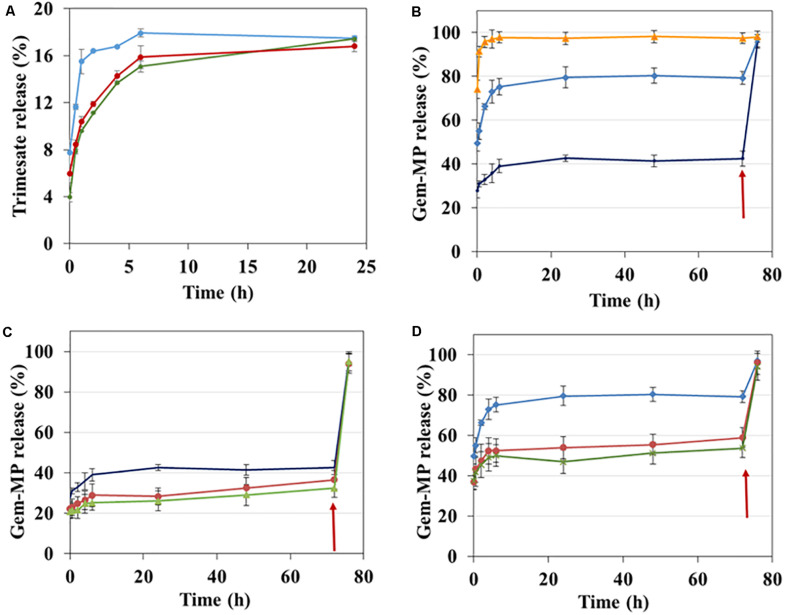
Effect of surface modification on Gem-MP and trimesate release analyzed by HPLC. (A) Trimesate release in 1 mM PBS from nanoMOFs before (blue) and after lipid coating with (red) or without (green) coating with PEG-lipid conjugates after incubation at 37°C. (B) Gem-MP release from uncoated nanoMOFs in PBS with different molarities (orange: 6 mM, blue: 3 mM; dark blue: 1 mM). Gem-MP release in 1 mM (C) or 3 mM (D) PBS from nanoMOFs before (blue/dark blue) and after lipid coating with (red) or without (green) coating with PEG-lipid conjugates. In all cases (B–D), phosphate concentration was adjusted to 10 mM after 72 h incubation at 37°C (red arrows), followed by further incubation for 4 h at 37°C.